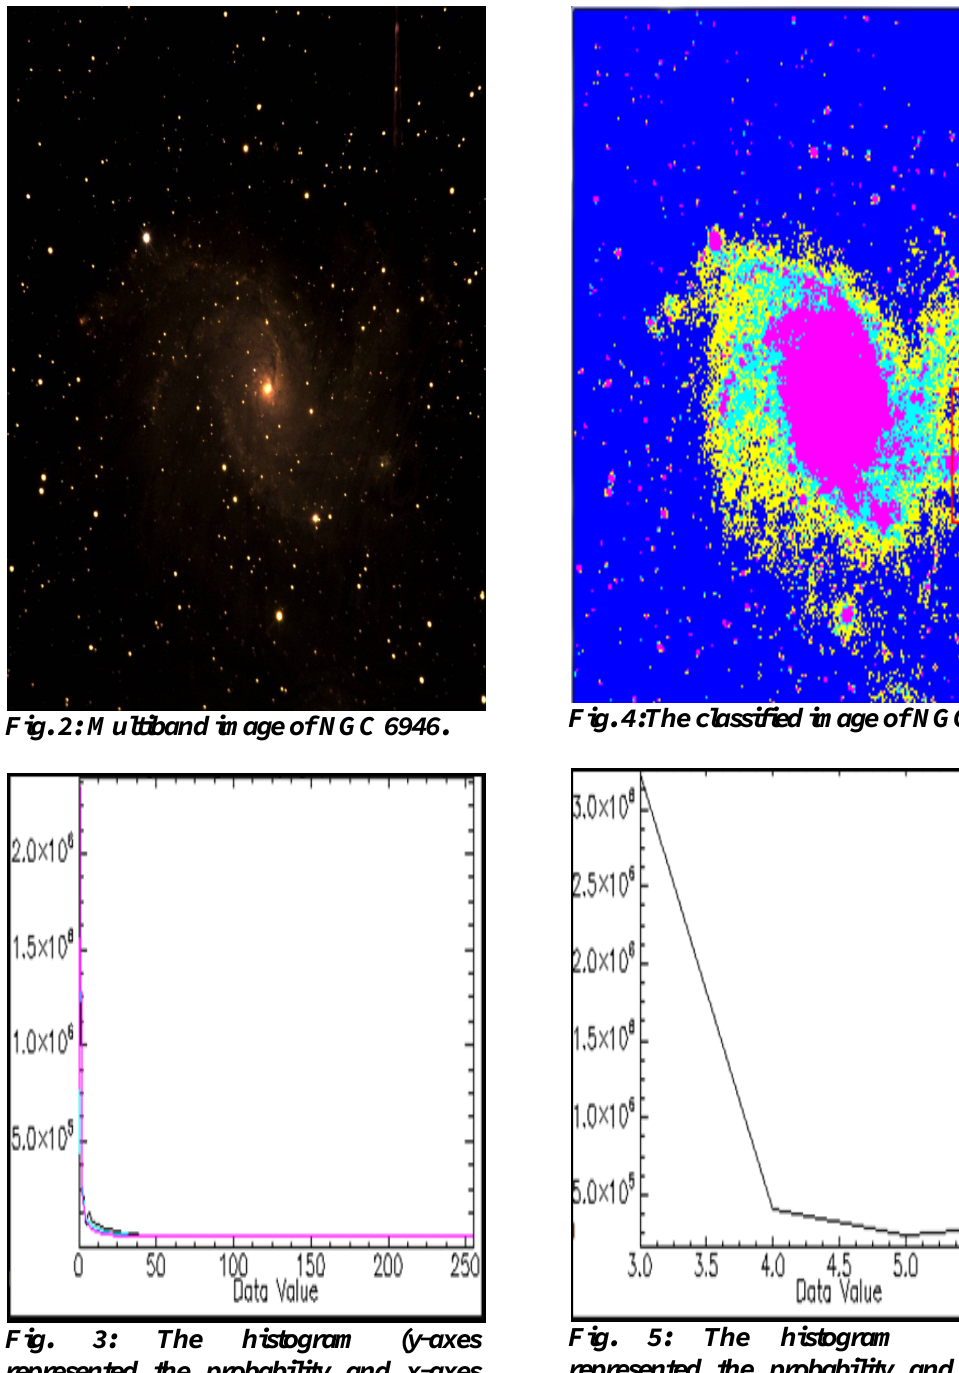
Fig. 5: The histogram (y-axes represented the probability and x-axes represented the intensity) of classified NGC